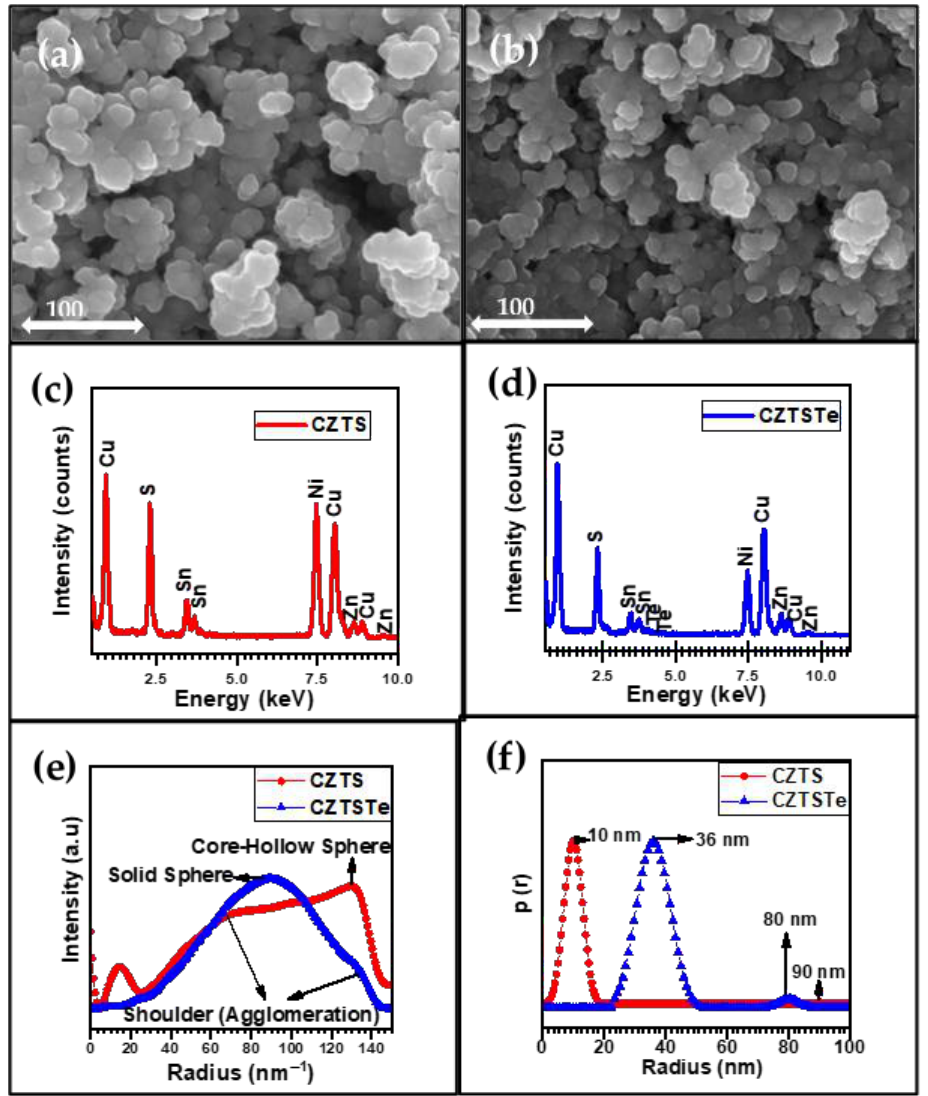
Figure 1. SEM micrograph of ( a ) copper zinc tin sulfide (CZTS) and ( b ) copper zinc tin sulfide telluride (CZTSTe). Energy-dispersive X-ray spectrometer (EDS) spectra of ( c ) CZTS and ( d ) CZTSTe. Small-angle X-ray scattering (SAXS) spectra for ( e ) shape and ( f ) size plots {p(r) represents distance distribution function}.